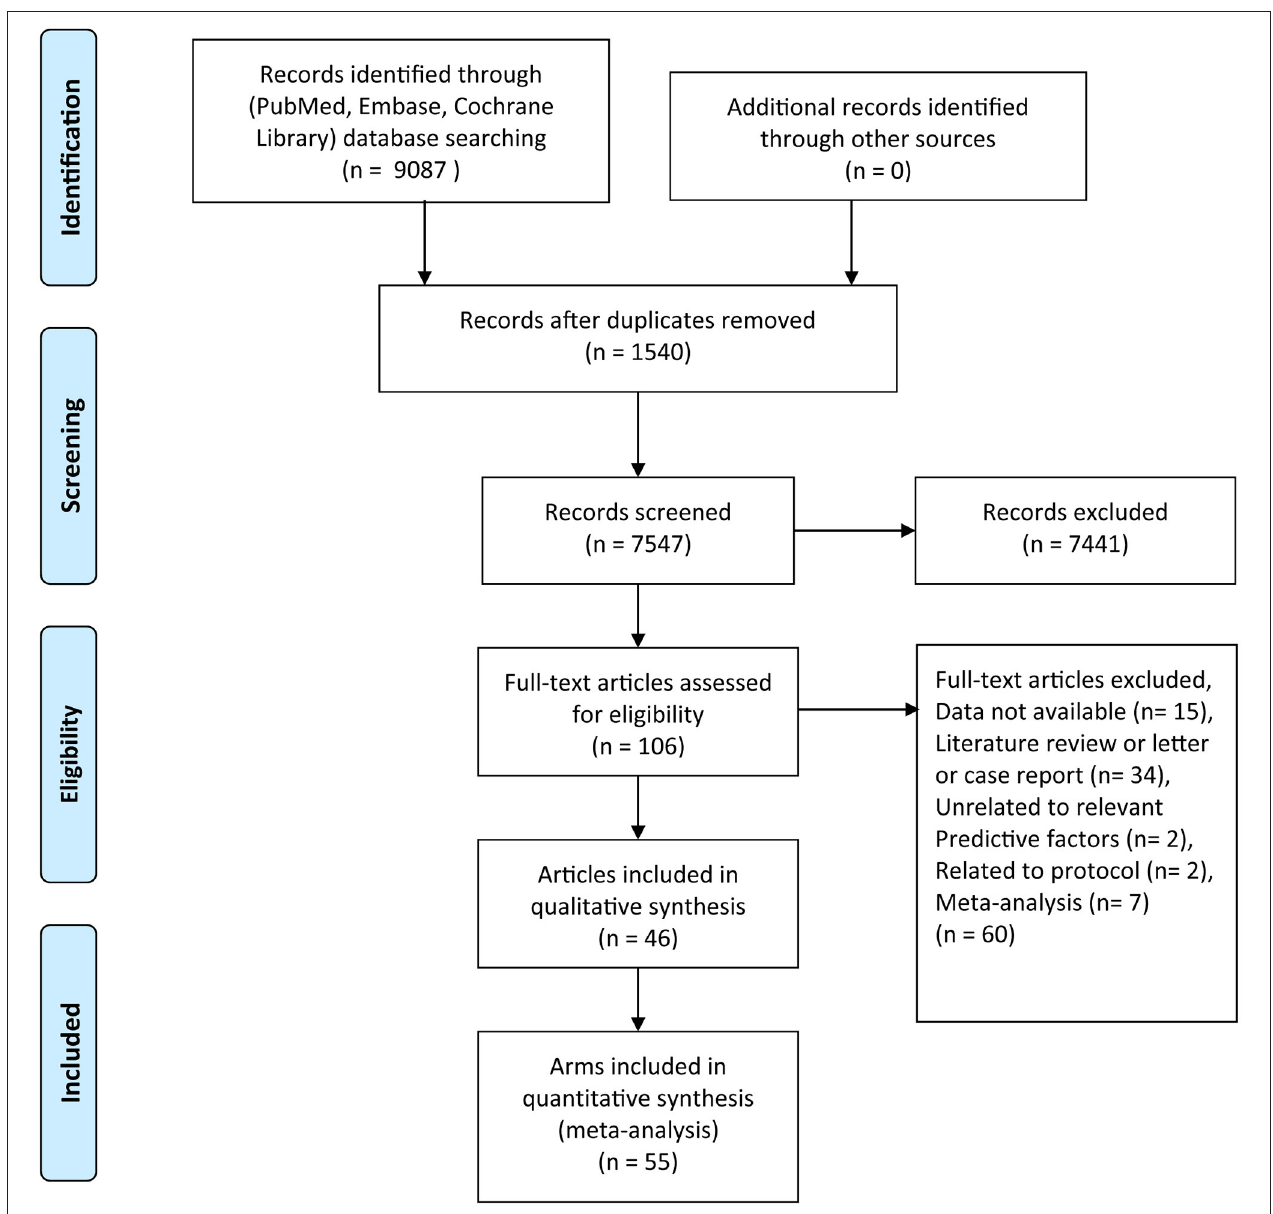
FIGURE 1 | Schema of the search